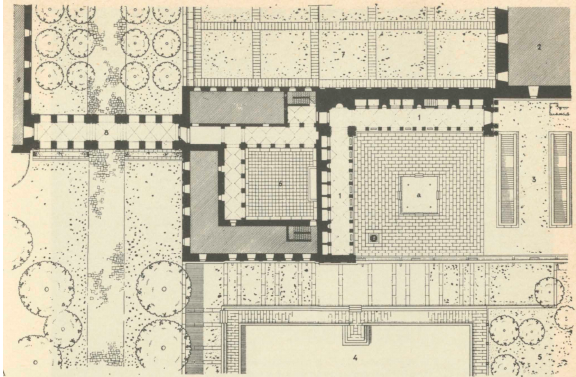
Figure 2. Secundino Zuazo, 1948: ground floor plan at the level of the Jardín de los Frailes , showing the ensemble of the Galería de Convalecientes and the Botica (see reference [11]).